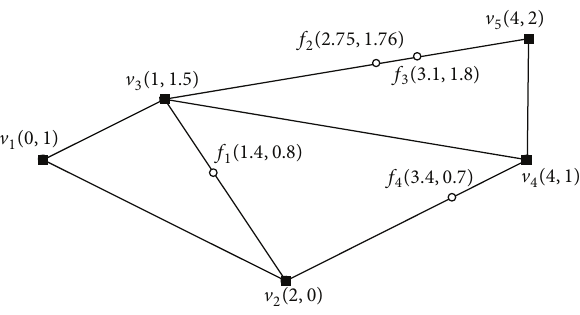
Figure 2: An example of road network.